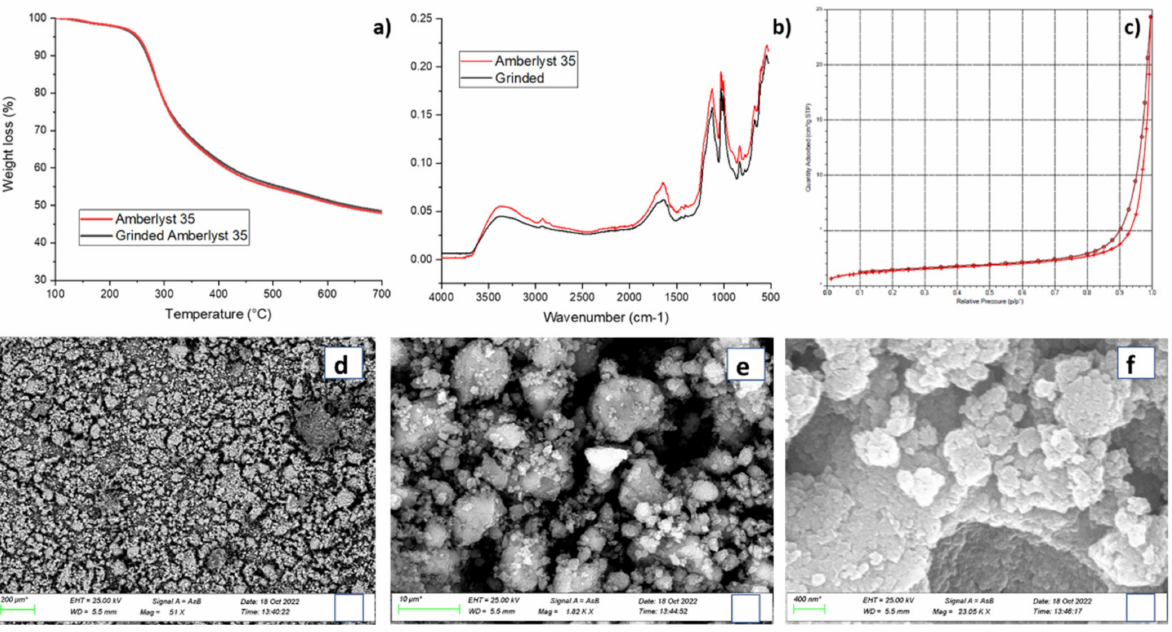
Figure 2. ( a ). TGA analysis of commercial AR-35 (red) and AR-35 after grinding process (black). ( b ) ATR-FTIR analysis of neat AR-35 (red) and ground AR-35 (black). ( c ) BET surface analysis of ground AR-35. ( d ) A 51 × microstructure overview of sample AR-35. To better analyze the structures of the sample, the AsB backscatter method was used. ( e ) An 1800 × image of ground AR-35. ( f ) A 23,000 × image of ground